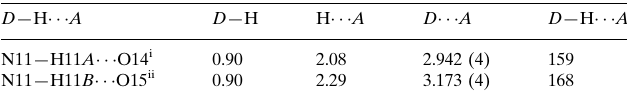
Hydrogen-bond geometry (A˚ , (cid:4)